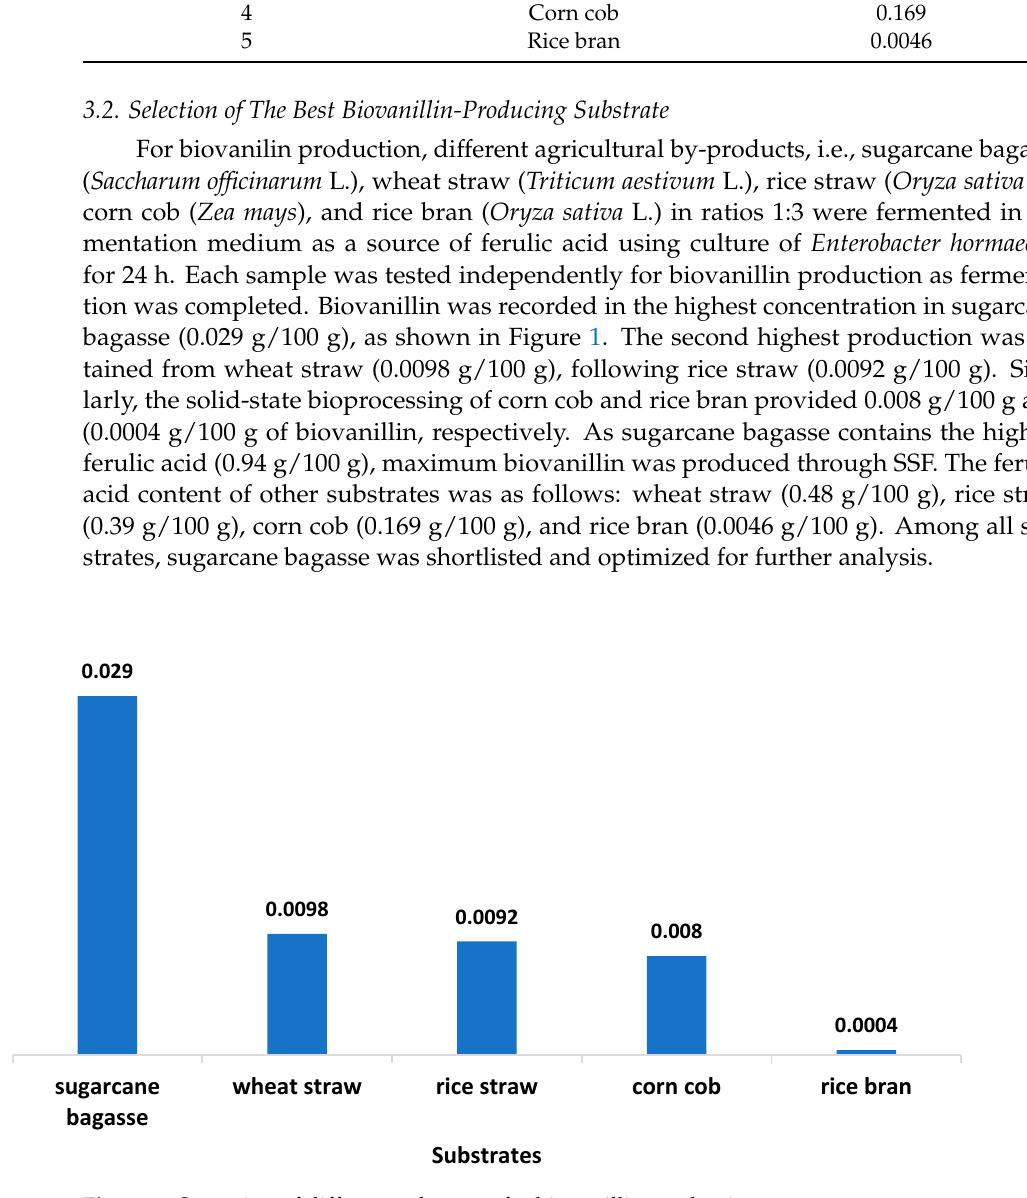
Figure 1. Screening of different substrates for biovanillin production.